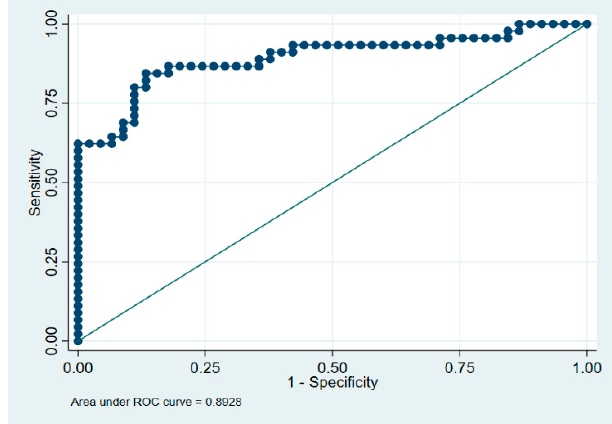
Figure 2. The ROC curve of the model two years before failure.